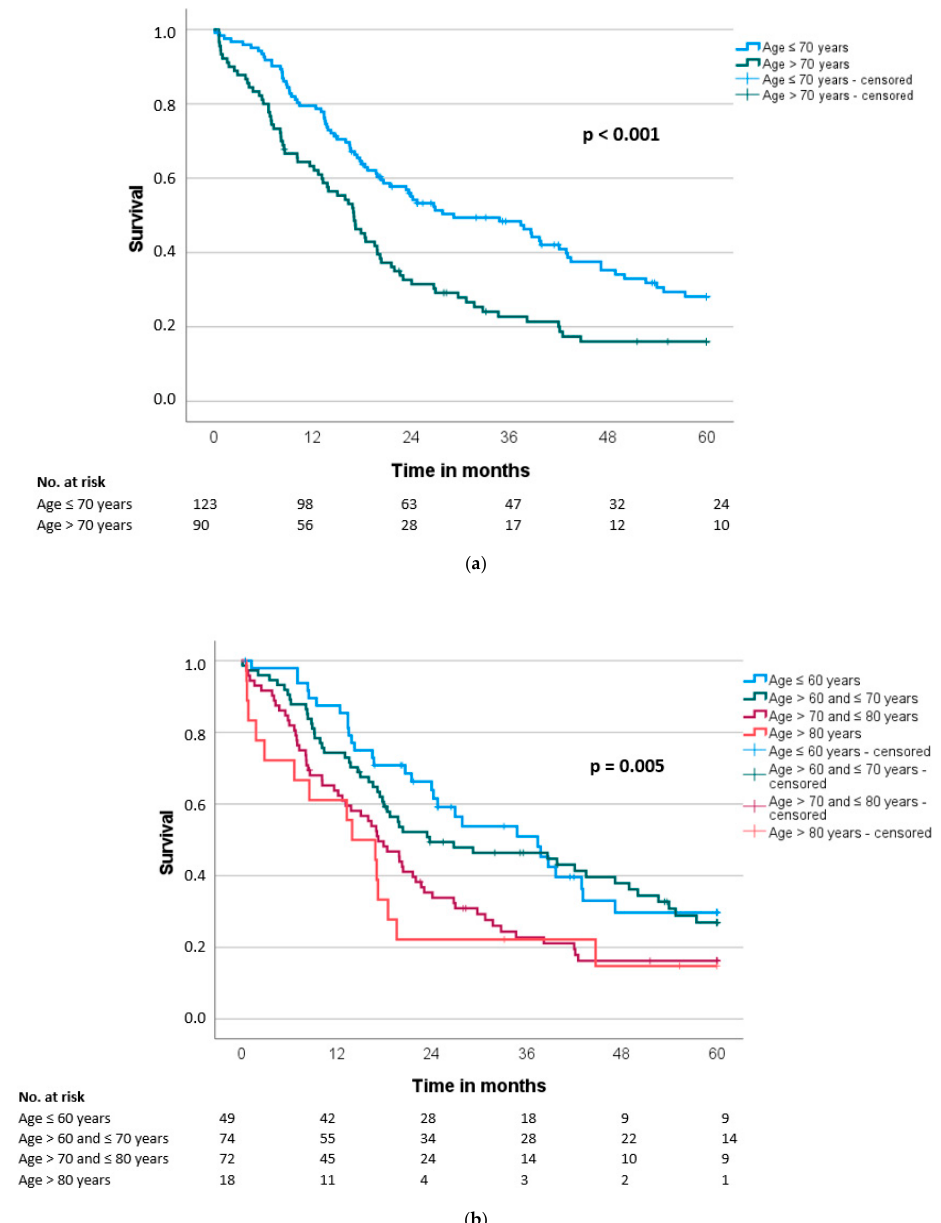
Figure 2. ( a ) Overall survival (OS) according to patients’ age ( ≤ 70 vs. >70 years) ( n = 213). ( b ) Overall survival (OS) according to patients’ age ( ≤ 60 vs. >60 and ≤ 70 vs. >70 and ≤ 80 vs. >80 years) ( n =